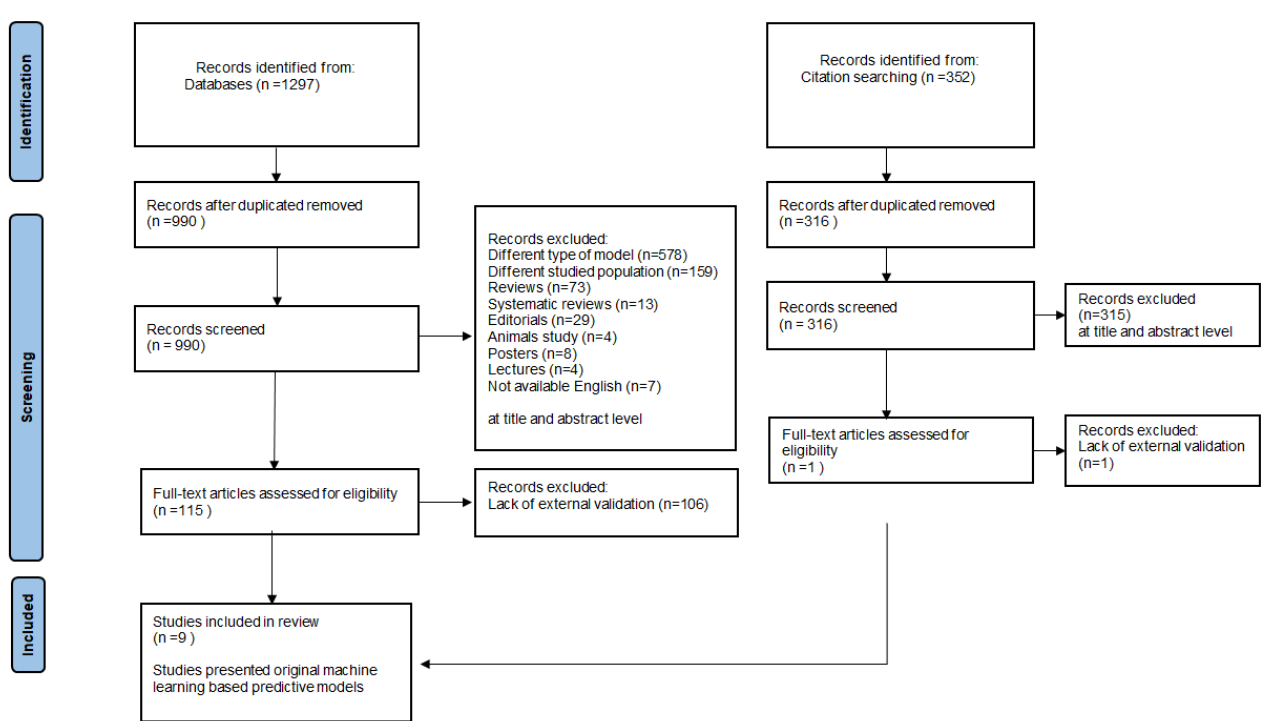
Figure 1. Flow chart of the systematic literature research.